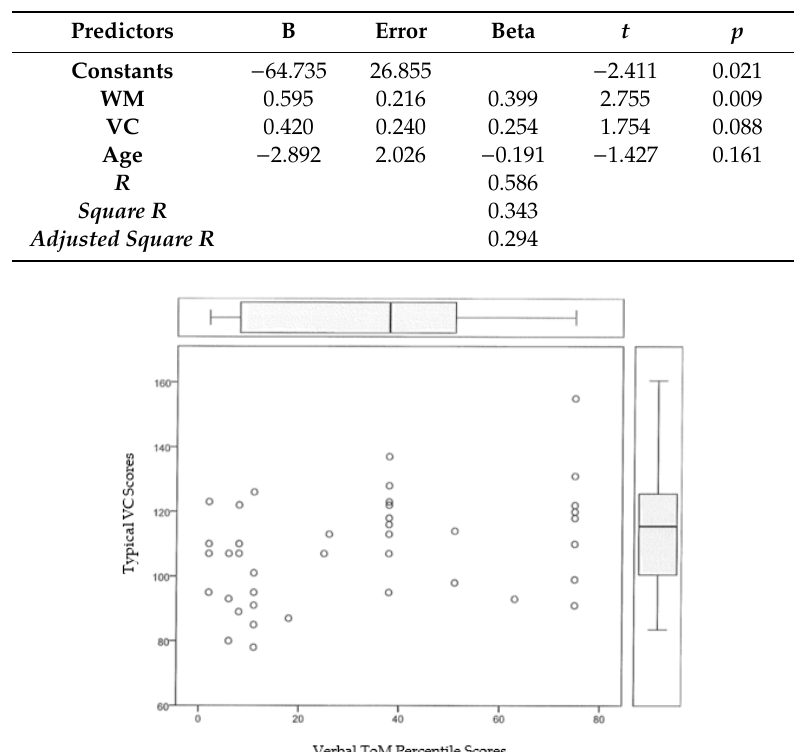
Table 2. Predictive validity of independent variables on dependent variables.